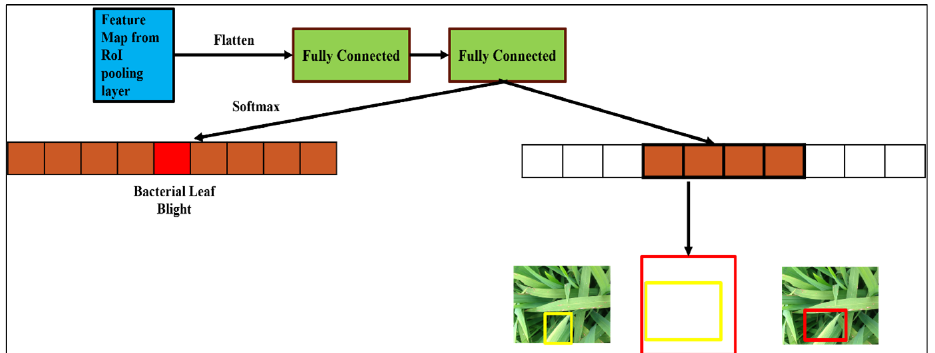
Figure 6. Output of RoI pooling layer of rice grade